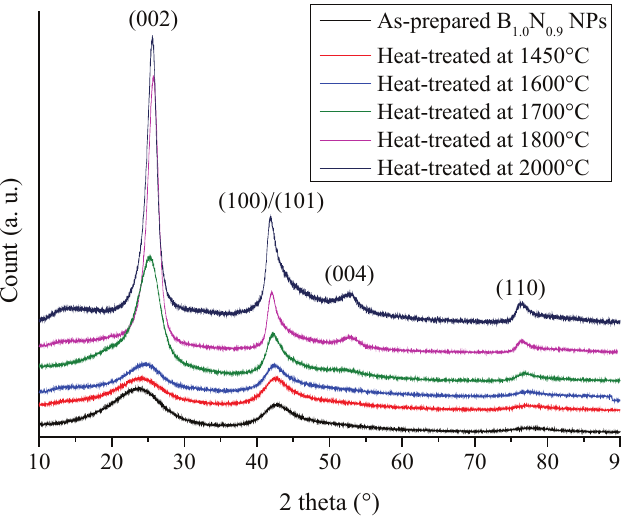
Figure 2. XRD patterns of borazine-derived B ranging from 1450 to 2000